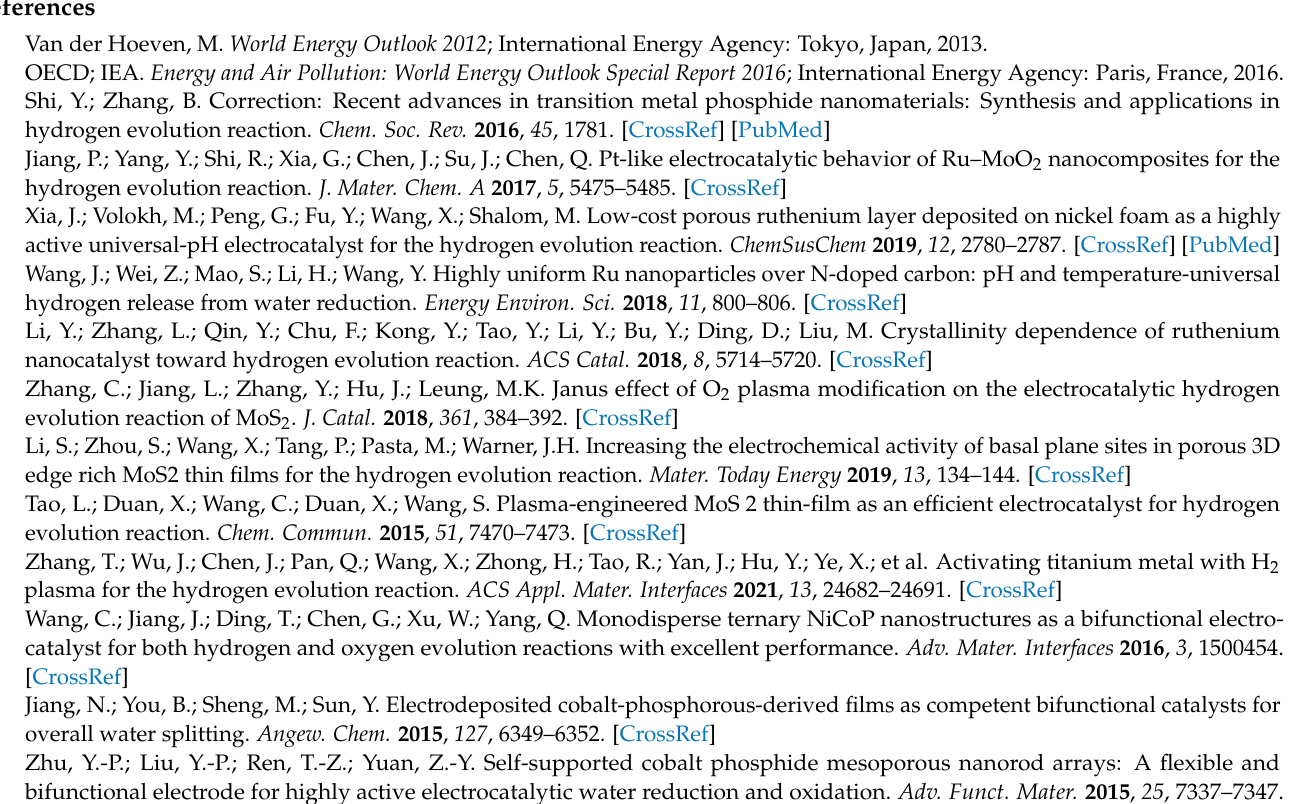
Figure S2: XPS spectra of Ru3d for the catalytic activity of (a) pristine NF, (b) NF*, (c) Ru/NF*, (d) Ru/NF*-A, (e) Ru/NF*-AH, (f) Ru/NF*-AO.; Figure S3: XPS spectra of O1s for the catalytic activity of (a) pristine NF, (b) NF*, (c) Ru/NF*, (d) Ru/NF*-A, (e) Ru/NF*-AH, (f) Ru/NF*-AO.; Figure S4: XPS spectra of Ni2p for the catalytic activity of (a) pristine NF, (b) NF*, (c) Ru/NF*, (d) Ru/NF*-A, (e) Ru/NF*-AH, (f) Ru/NF*-AO.; Figure S5: LSV polarization curves for HER cat- alyzed by Ru/NF*-AO before and after a durability test in (a) 1 M KOH, (a) 0.1M PBS, and (c) 0.5 M H2SO4 aqueous